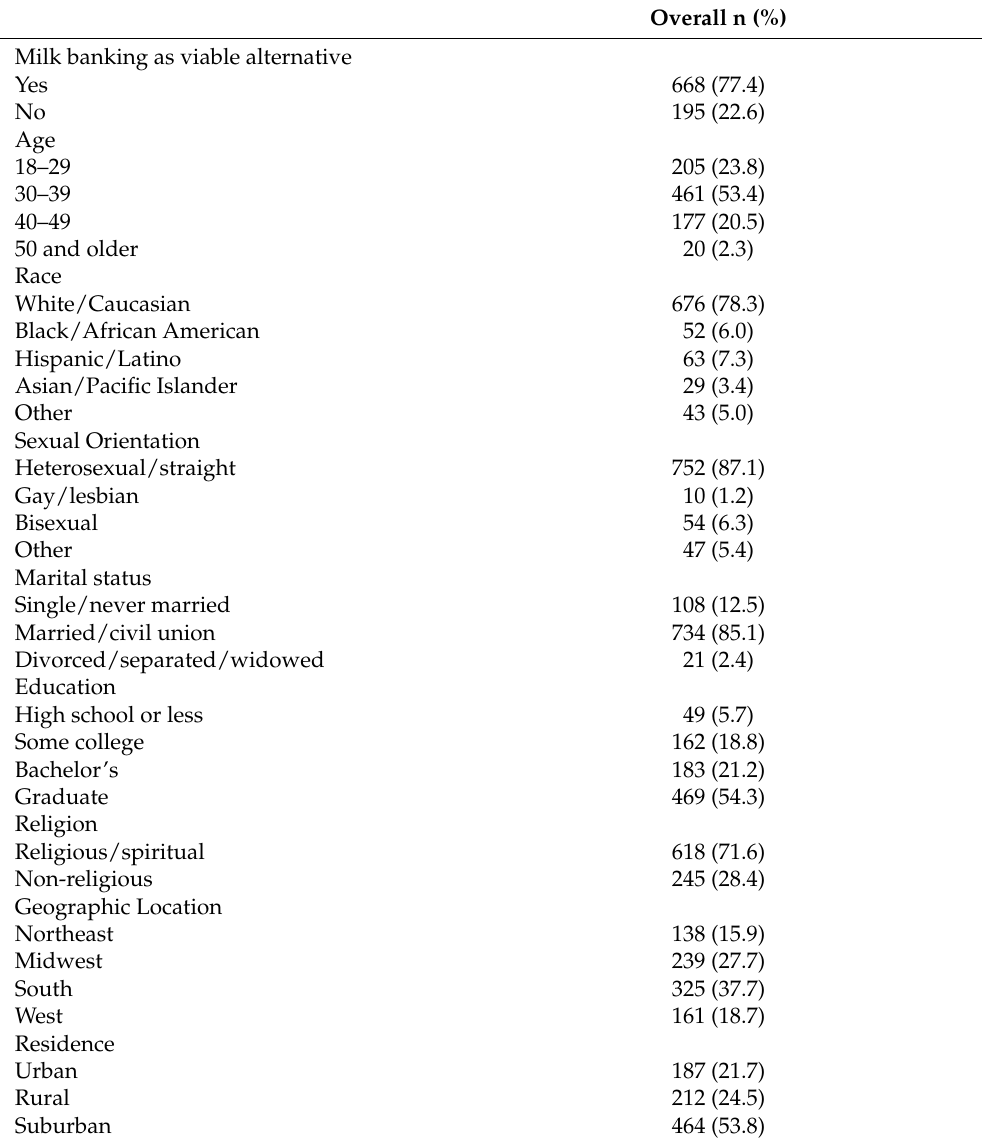
Table 1. Descriptive statistics of the study sample ( N =